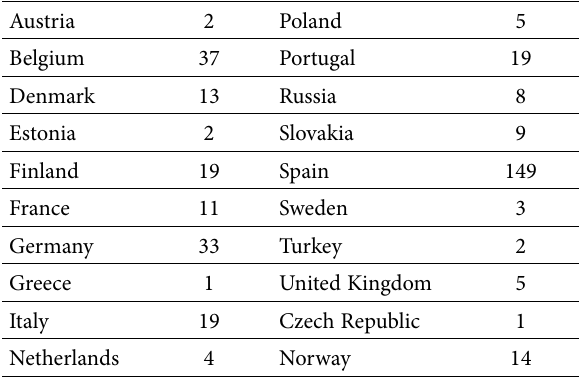
Table 1. Number of submissions per country involved in the Representiveness Survey